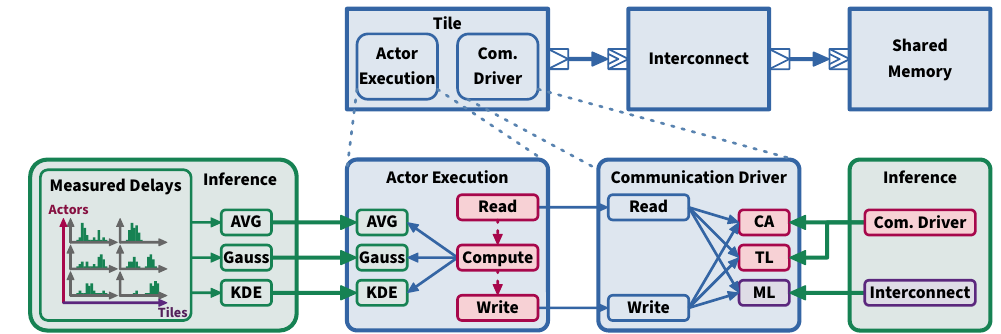
Figure 5. Architecture of our SystemC simulation showing how our models are integrated. The delay models themselves (including hardware delay) are part of the SDF execution on a tile within the simulation. The model of executing code on a tile is split into two parts. The Actor Execution corresponds to the actual execution of an SDF actor on a